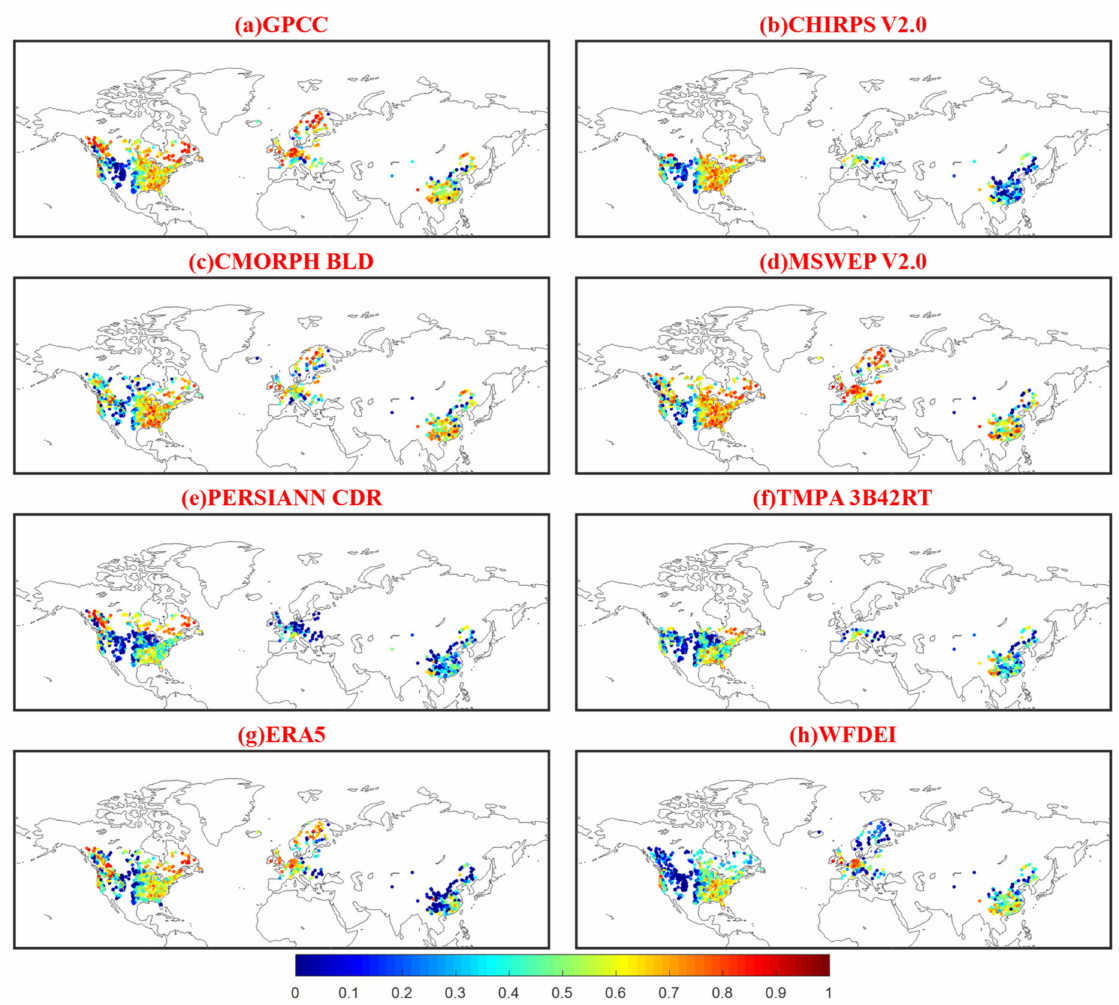
Figure 6. Spatial patterns of NSE for the eight PPs (( a ) GPCC, ( b ) CHIRPS V2.0, ( c ) CMORPH BLD, ( d ) MSWEP V2.0, ( e ) PERSIANN CDR, ( f ) TMPA 3B42RT, ( g ) ERA5, ( h ) WFDEI) obtained by running XAJ with ‘RP’ over 1382 catchments (step